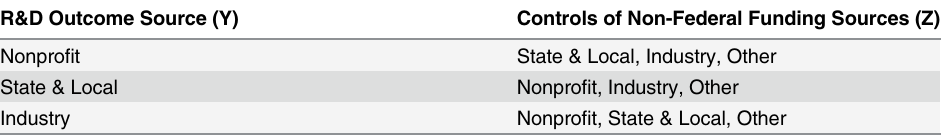
Table 2. R&D Outcome Source and Respective